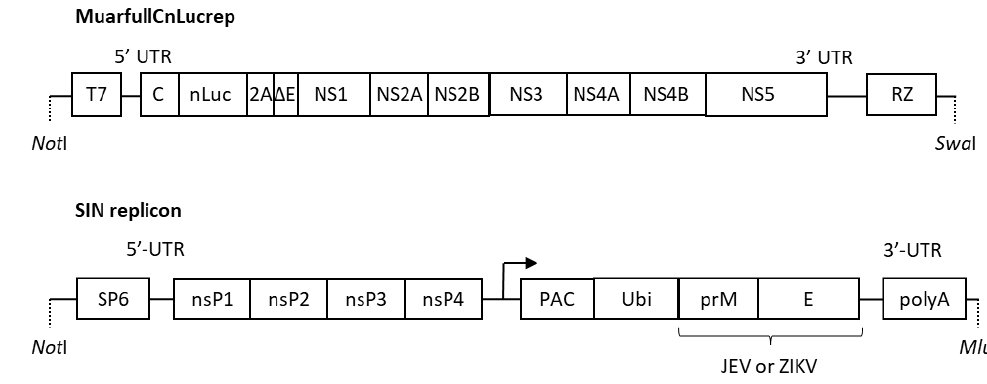
Figure 1. Structure of MuarfullCnLucrep and the Sindbis virus replicon (SIN replicon). MuarfullCnLucrep and the SIN replicon were constructed into a pACYC177-based plasmid and a pToto1101-based plasmid, respectively. The backbone structures of these plasmids were omitted in this figure. NS—non-structural protein of Japanese encephalitis virus. 2A—foot-and-mouse disease virus derived 2A protein. RZ; hepatitis delta virus ribozyme. nsP—non-structural protein of sindbis virus. PAC—puromycin N-acetyl-transferase. Ubi—ubiquitin. Arrow indicates secondary promotor of the sindbis virus genome. Table 1. Amino acid substitutions among JEV GV strains.